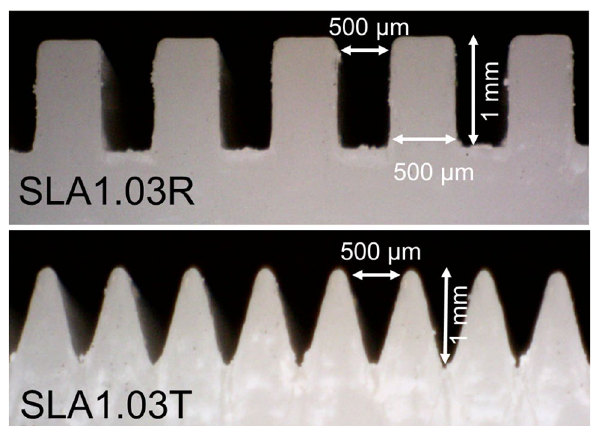
Figure 8. Two cross-sectional micro-groove geometries considered, rectangular (SLA1.03R) and triangular (SLA1.03T) cross-sections, made with stereolithography (SLA). The triangular cross-section has a higher capillary height as compared to the rectangular one. Table 1 lists the sample